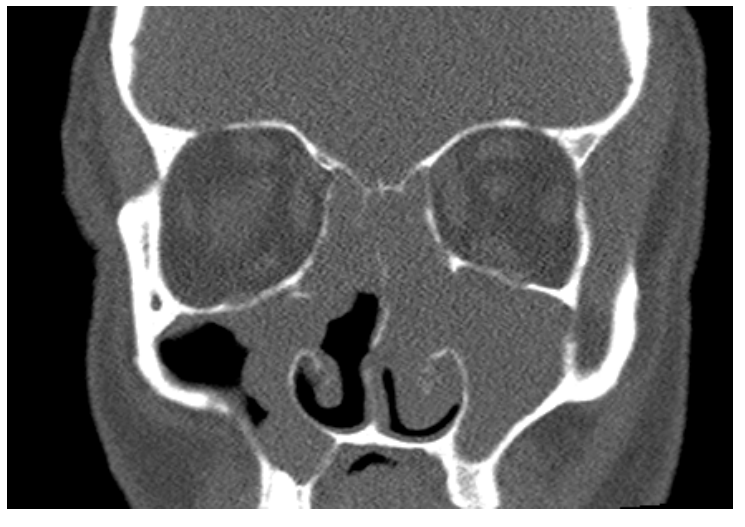
Figure 3. The computerized tomography (CT) coronary scan—chronic rhinosinusitis with nasal polyps. Male, 54 years old (from co-author’s archive).